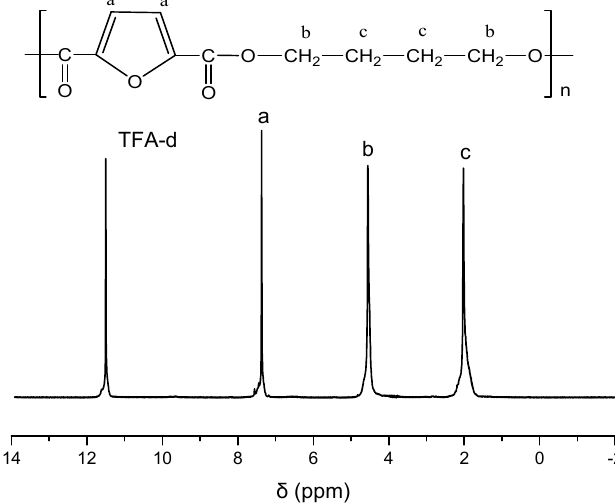
Figure 1. 1 H NMR spectrum of poly(butylene 2,5-furandicarboxylate) (PBF).